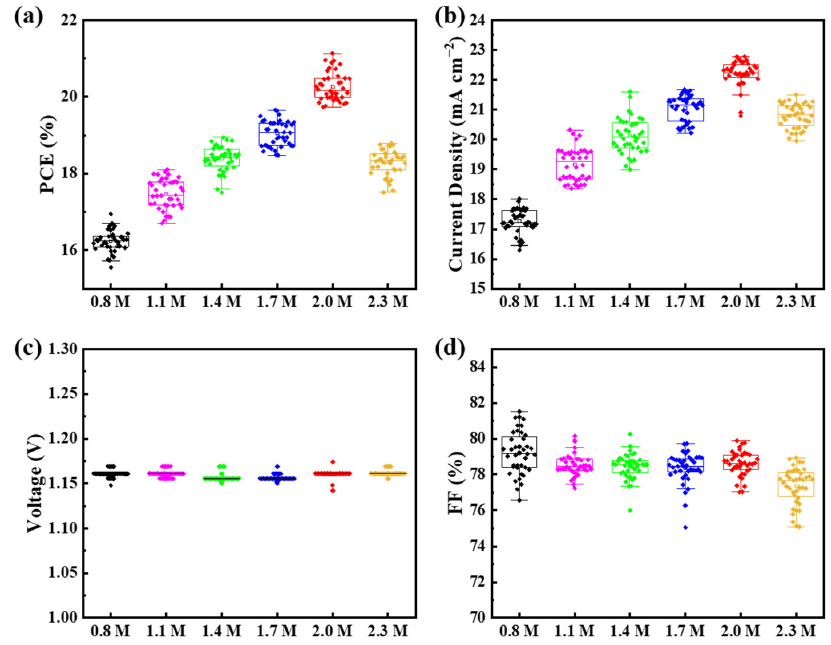
Figure 5. Performance distribution of PSCs. ( a ) PCE, ( b ) J SC , ( c ) V OC , ( d ) FF.